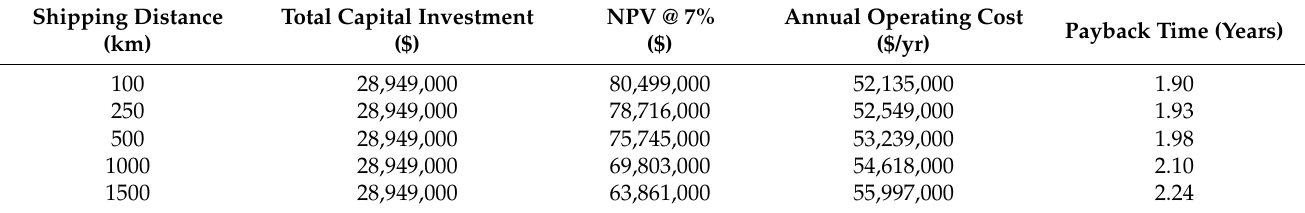
Table 13. The effect of product shipping distance to centralized facilities on process economics. Shipping